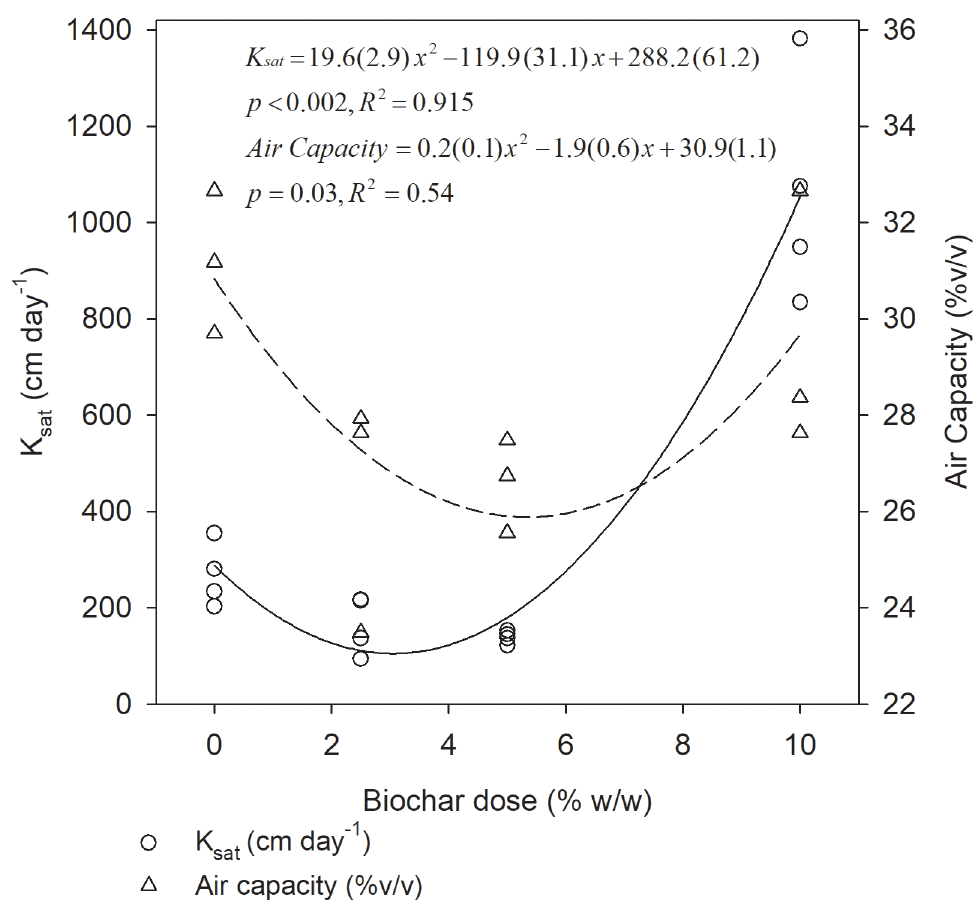
Fig 2. K sat and air capacity of heavy clay soil at various BC doses, for four and three replicates, respectively. The numbers in brackets in the equations are the standard errors. The soil is from plough layer of heavy clay in West Timor,